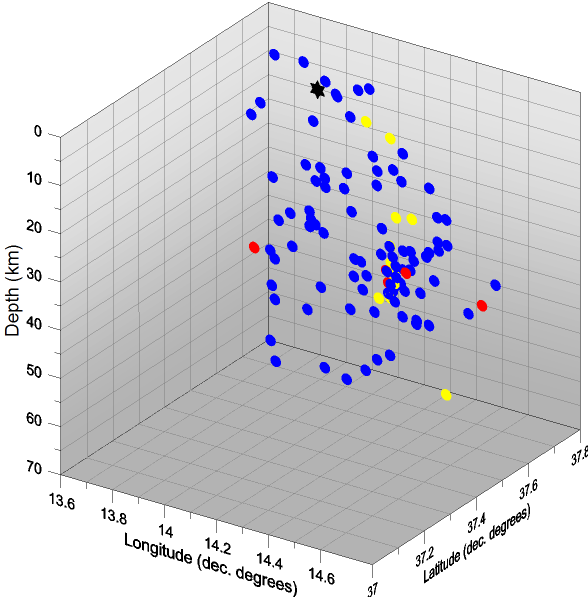
Fig. 12. Hypocentral location of all the seismic events recorded in Central Sicily during the 2002–2009 period. Red circles are the August 2008 events, yellow circles the August 2009 events, blue circles all the others. The black star is the Santa Barbara